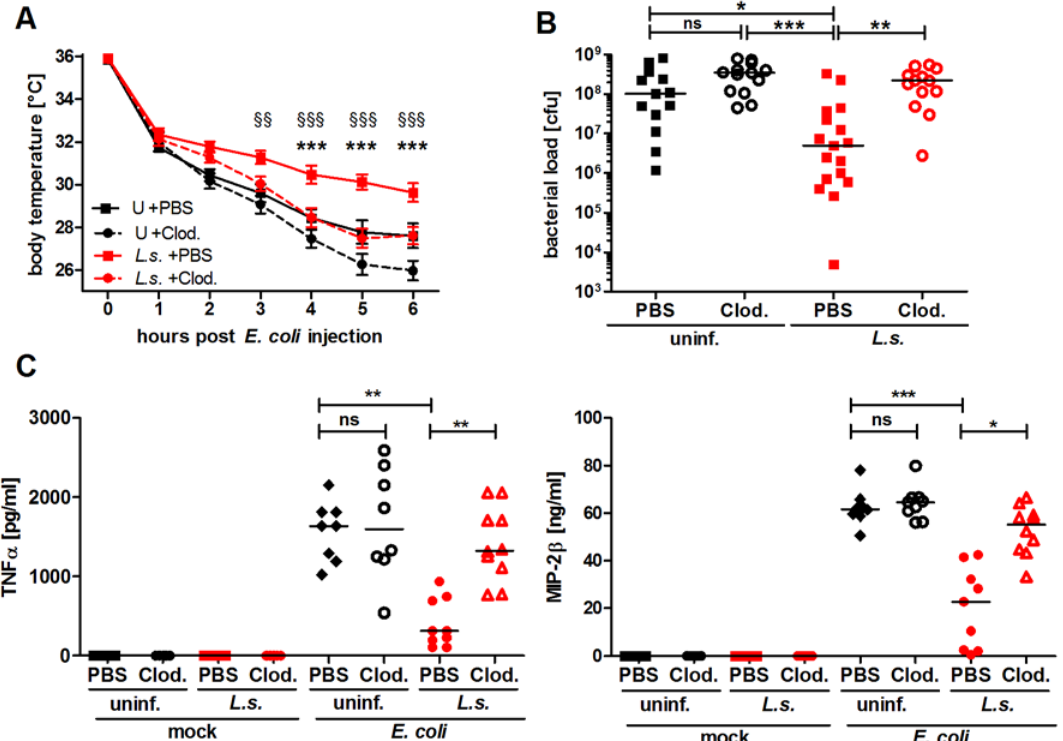
Figure 2. Macrophage depletion renders L. sigmodontis -infected mice susceptible to E. coli -induced sepsis. Chronic L. sigmodontis ( L.s. )-infected BALB/c mice and uninfected controls (U) were i.p. injected with Clodronate- or PBS-containing liposomes before E. coli injection. ( A ) Kinetic of E. coli - induced hypothermia. ( B ) Peritoneal bacterial load and ( C ) serum TNF α and MIP-2 β levels six hours after E. coli injection or mock treatment. ( A ) and ( B ) show pooled data from three independent experiments with at least 4 mice per group. ( C ) Pooled data from two independent experiments (mock treatment single experiment). Data in ( A ) is displayed as mean +/- SEM and was tested for statistical significance by 2-way ANOVA and Bonferroni post-hoc test (asterisks indicate significant differences between L.s. + PBS (n = 17) and L.s. + Clod. (n = 16), paragraphs indicate significant differences between L.s. + PBS and U + PBS (n = 15) treated mice (U + Clod. n = 13); in ( B ) and ( C ) data is presented as median and was tested for statistical significance by 1-way ANOVA followed by Dunn ’ s post-hoc test comparing only E. coli -treated groups. * p < 0.05, ** p < 0.01, *** p < 0.001.